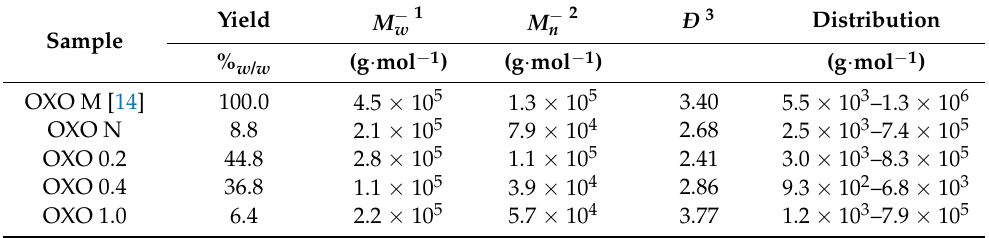
Table 1. Molecular dimensions of O. joconostle mucilage (extracted from the cladodes) and its composing polysaccharides found after ion exchange chromatography